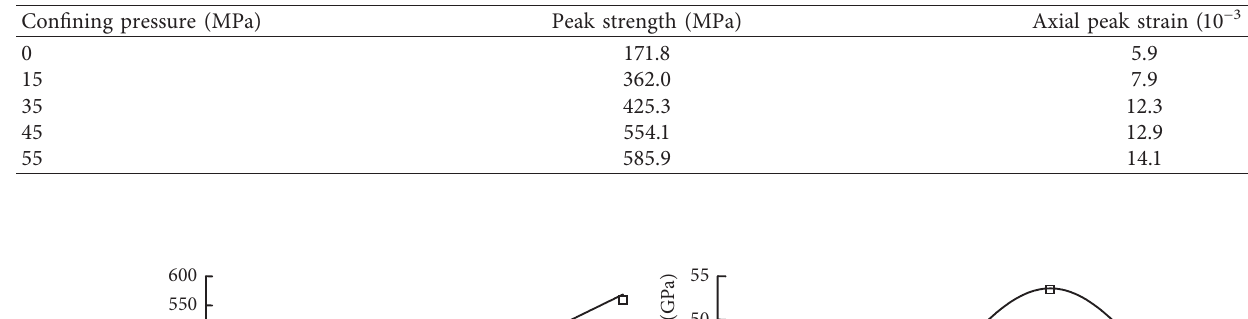
Table 4: Peak strength of cyclic loading and unloading under different confining pressures.